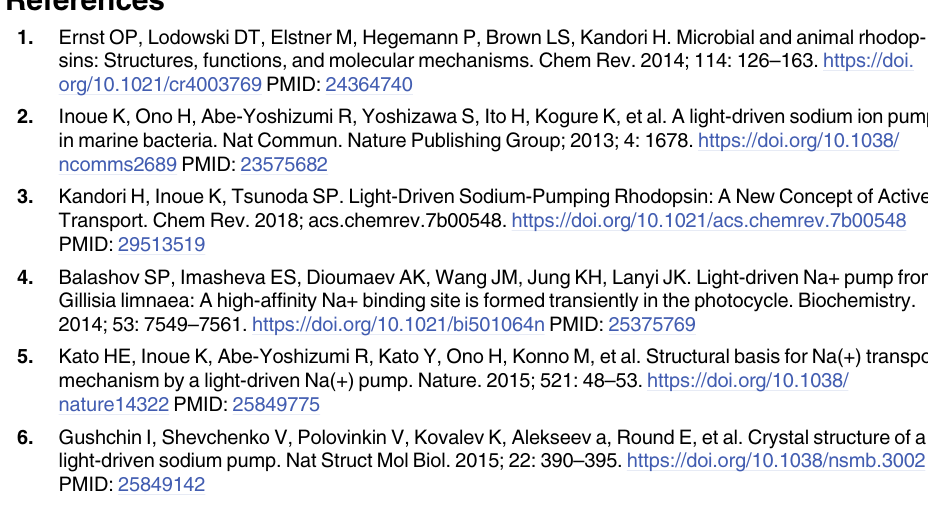
S2 Fig. Current-Voltage relation (I-V plot) under various ionic conditions. 532 nm LED light (25 mW/mm2) was illuminated to activate KR2. Extracellular solution contained 140 mM NaCl at pH 7.4 for all conditions. A-F, I-V plot in the absence of intracellular Na+. A-C: peak current. D-F: steady state current. A and D: pHi = 7.4; B and E: pHi = 8.0; C and F: pHi = 9.0. G-L, I-V plot in the presence of intracellular Na+. G-I: peak current. J-L: steady state current. G and J: pHi = 7.4; H and K: pHi = 8.0; I and L: pHi = 9.0. A and D: n = 7; B and E: n = 6; C and F: n = 3; G and J: n = 5; H and K: n = 5; I and L: n =